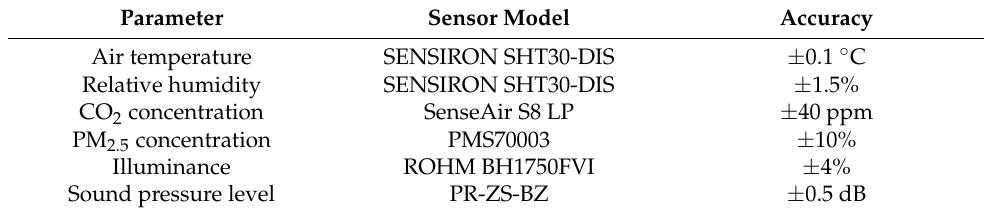
Figure 3. Physical design of the IEQ monitoring instrument. Table 3. Sensors and their